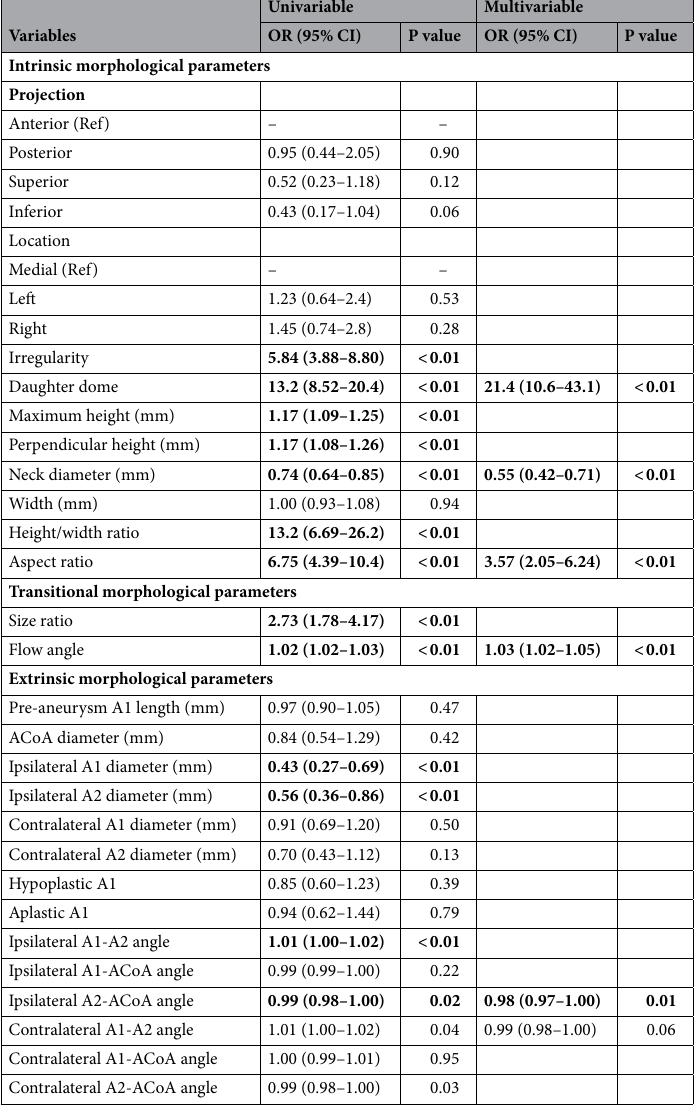
tions with female sex, years since quitting smoking, alcohol use, hypertension, coronary artery disease, history of ischemic stroke, and family history of aneurysms and SAH were also found.